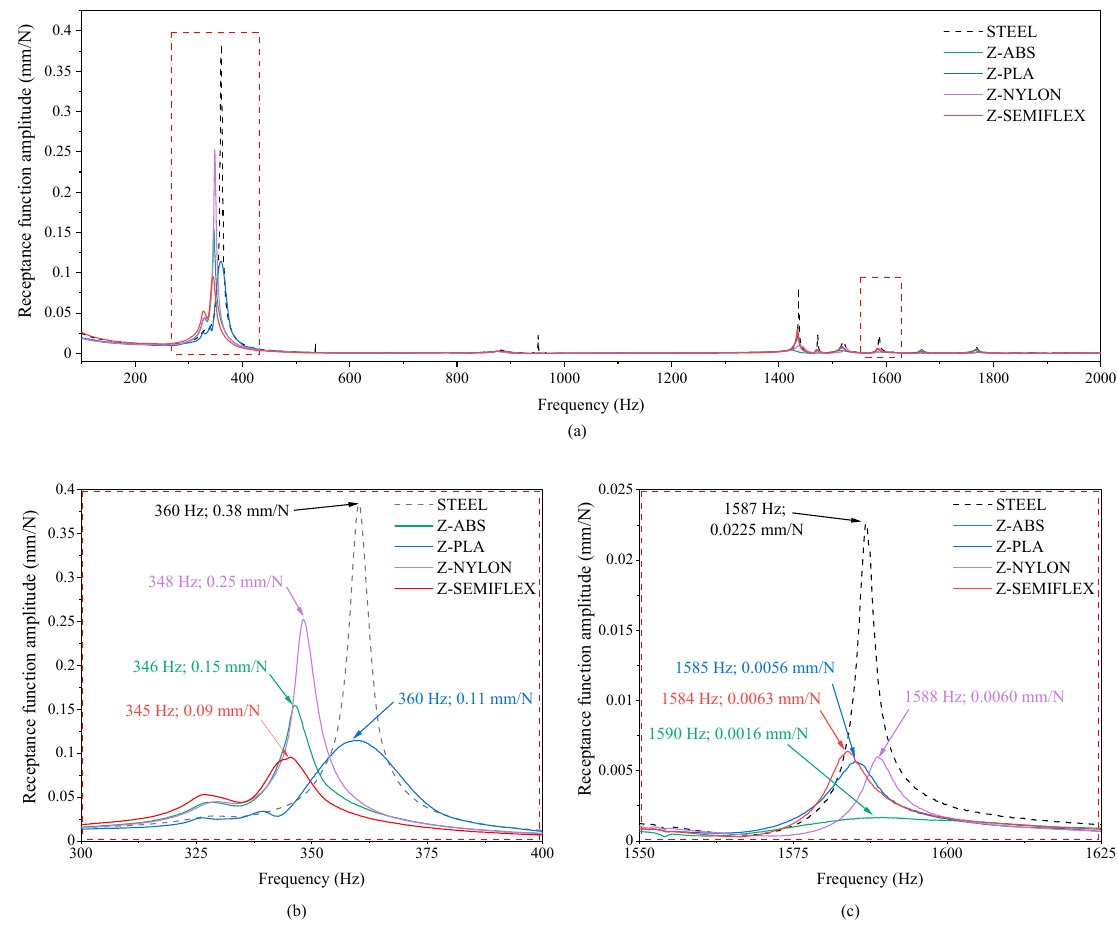
Figure 6. Comparison of the receptance functions amplitude for bare and dampened steel-frame ( a ), enlarged views of the receptance function in the frequency range from 300 Hz to 400 Hz ( b ) and from 1550 Hz to 1625 Hz ( c ).